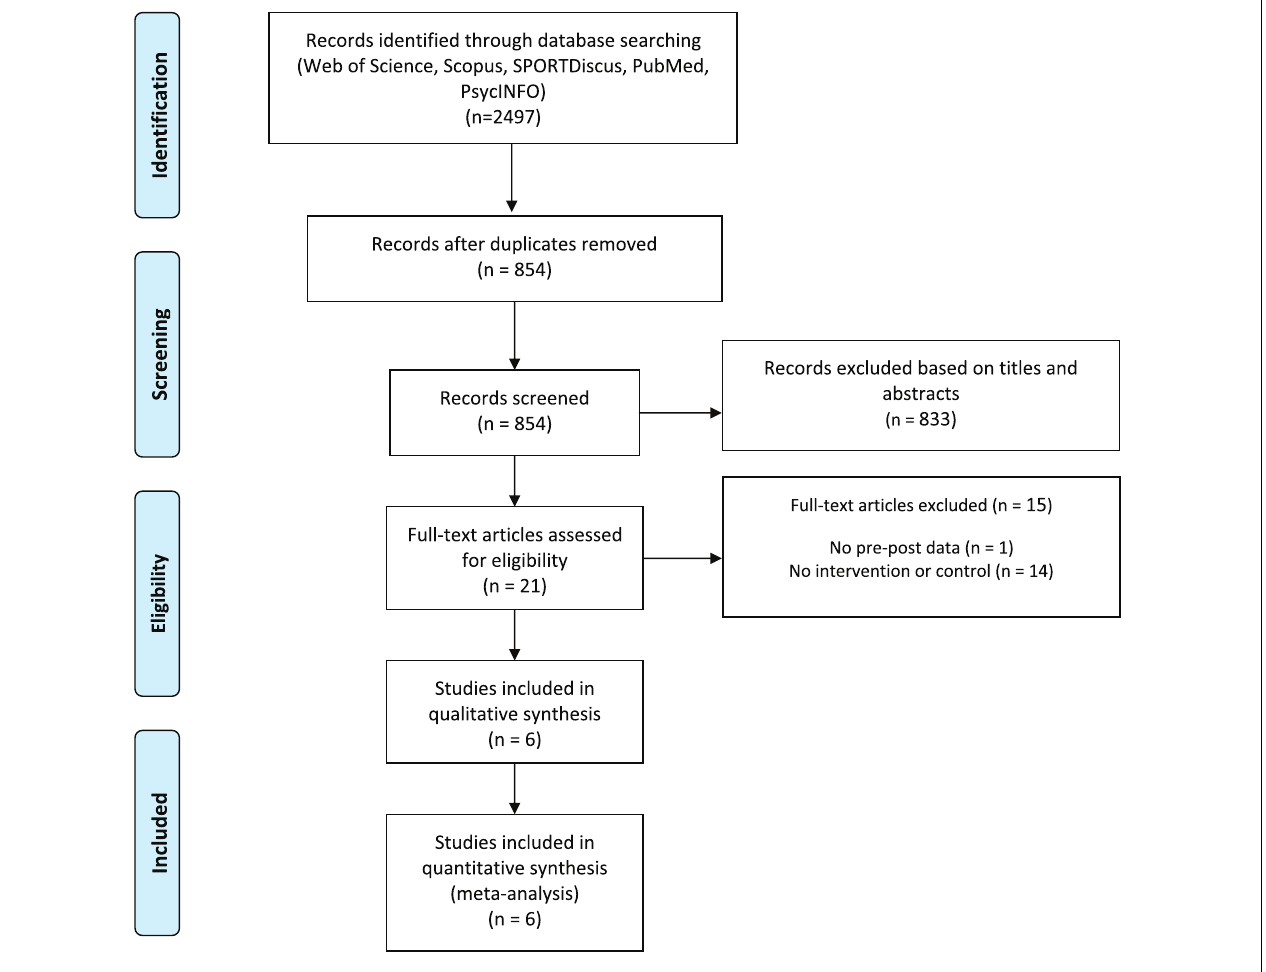
FIGURE 1 | PRISMA flow diagram highlighting the selection process for the studies included in the current systematic